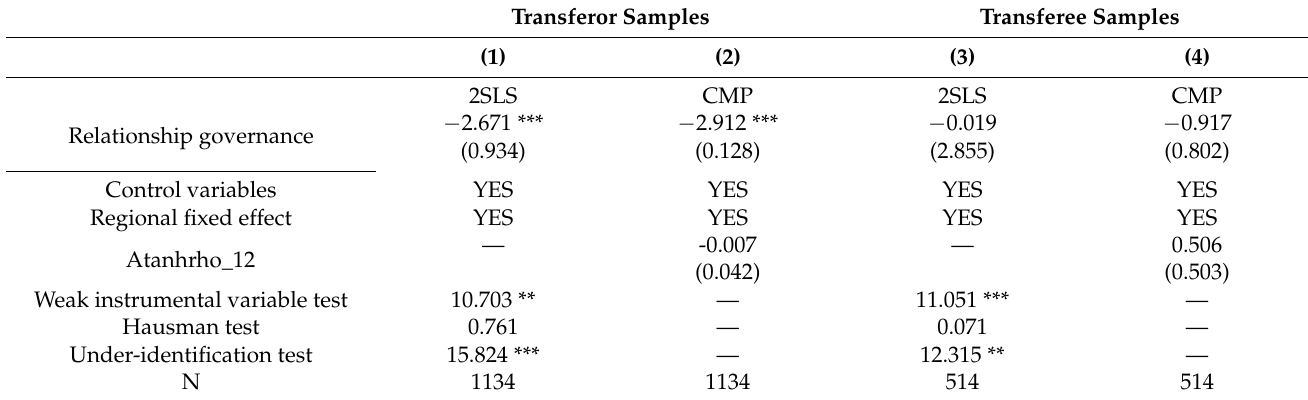
Table 6. Impact of relationship governance on transfer rent: endogeneity